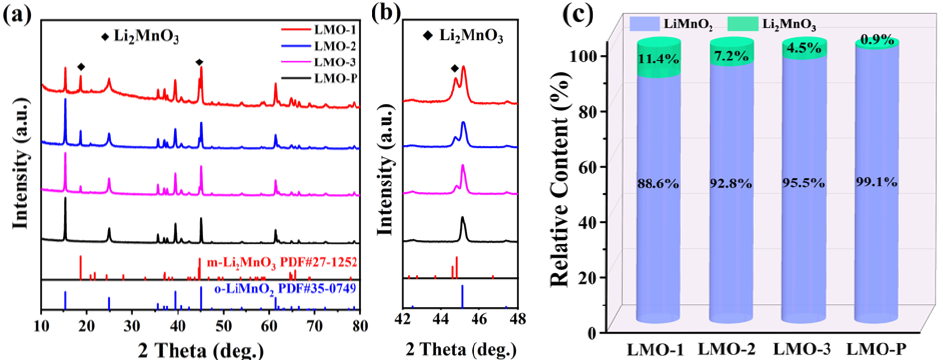
Figure 1. The XRD patterns ( a , b ) and ratio of the two phases ( c ) of the four synthesized samples. Table 1. The experimental results of the Li/Mn atom ratio, e Mn average valance, and corresponding calculated x-values.